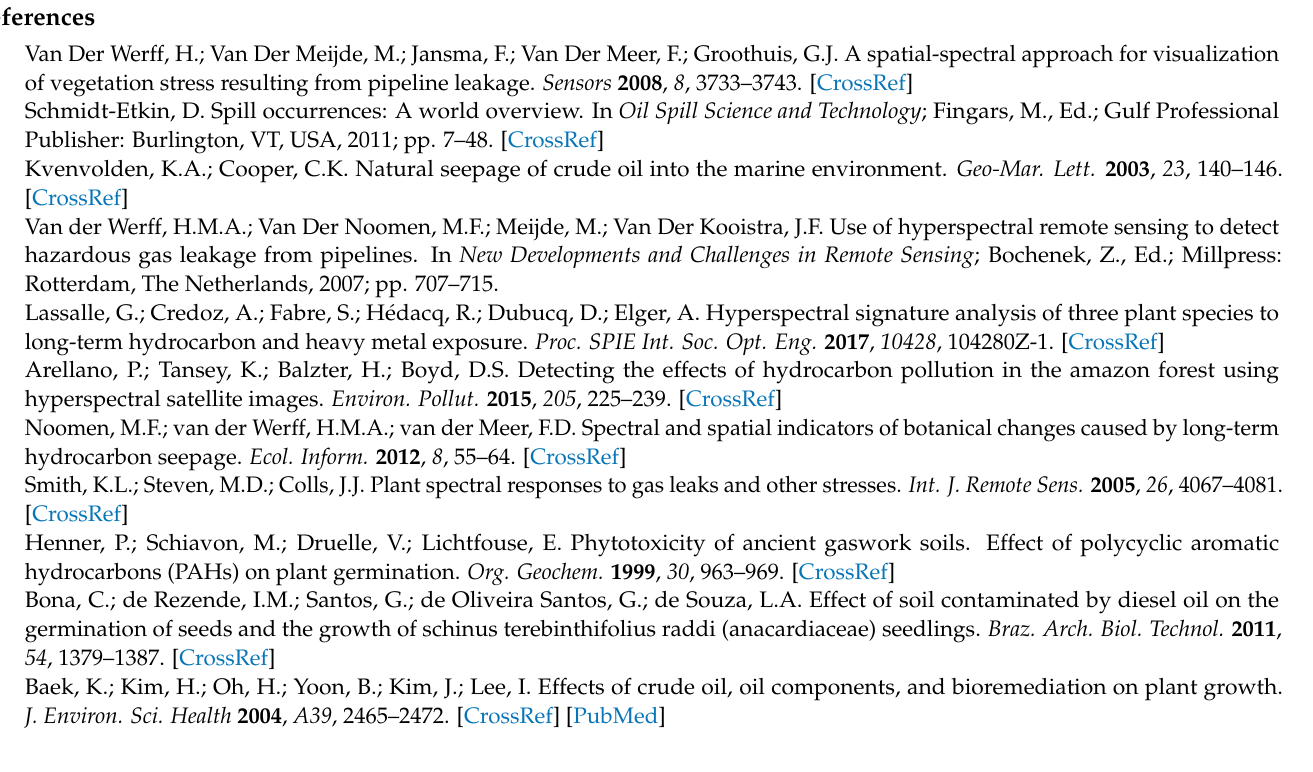
Figure S7: 2D histogram of absorption feature frequencies in refined oil treatments of willow trees, Figure S8: 2D histogram of absorption feature frequencies in crude oil treatments of maize plants, Figure S9: Band depth time series of 620, 957, and 1346 nm absorption features in refined oil treatments, Figure S10: Time series of vegetation indices in refined oil treatments, Figure S11: Red edge position in refined oil treatments in willow and maize plants, Figure S12: Red edge and in crude oil treatments, Figure S14: Photos of spectral measurements of the willow experiment, Table S1: Absorption features in refined oil treatments classified according to the appearance during the pollution event, Table S2: Absorption feature details and related biochemical components, Table S3: Spectral vegetation